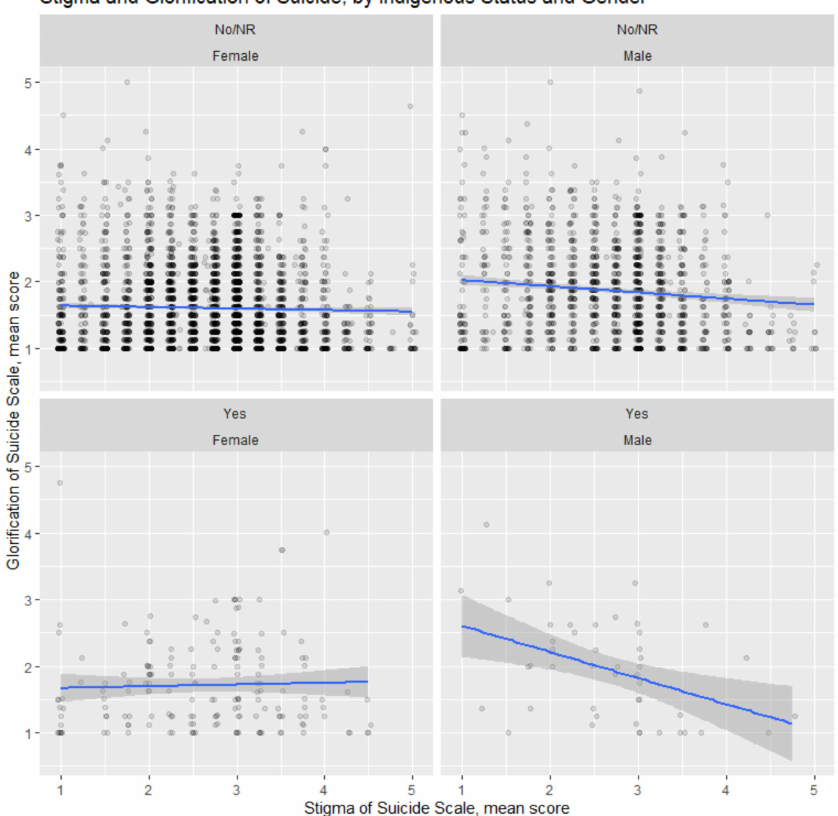
Figure 2. Visualisation of mean stigma and mean glorification scales faceted by sex and Indigenous